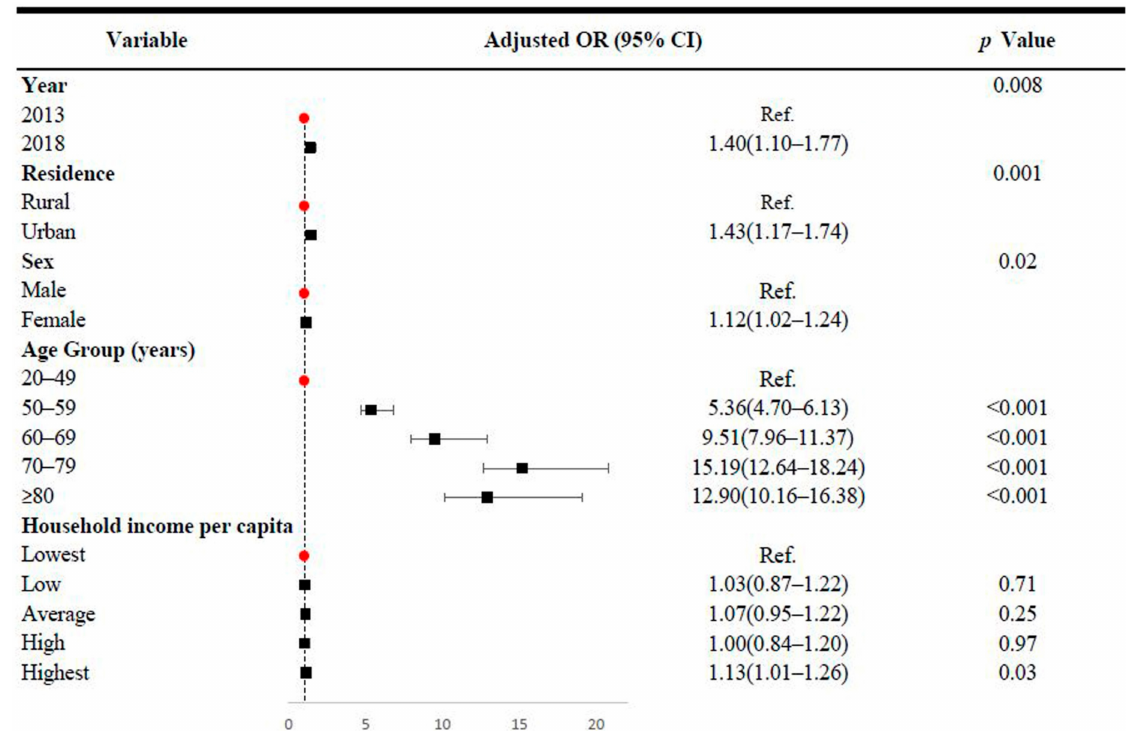
Figure 4. Associations between 6-month prevalence of circulatory system diseases and demographic variables in Hunan Province, China. OR: odds ratio; 95% CI: 95% confidence interval. Adjusted odds ratios were estimated after adjusting for year, residence, sex, age group and household income per capita. Due to small numerators, we combined age groups of 20–29 and 30–39 into a single group, 20–39, to obtain a stable rate. For the 2013 survey, households were divided into five categories: lowest (urban, CNY <6667; rural, CNY <3334); low (urban, CNY 6667–9999; rural, CNY 3334–4999);